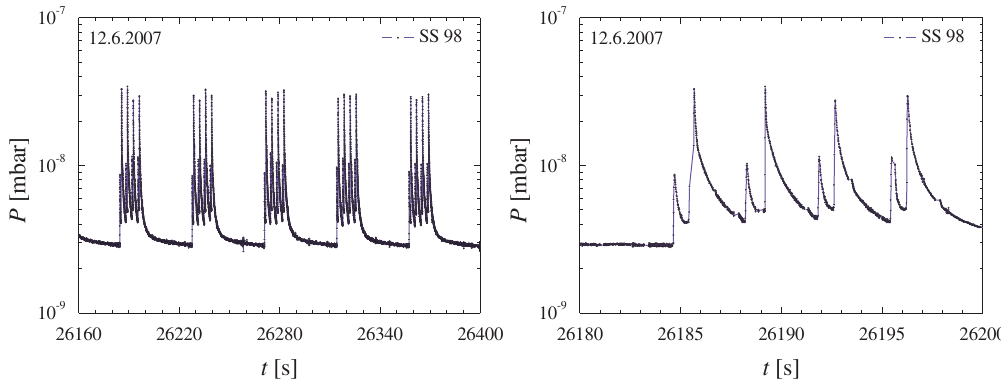
FIG. 3. (Color) Pressure rises in PS straight section 98 measured on 12/6/2007 at 21:38 during a PS supercycle that contained four nominal LHC beams. Right: Zoom into the pressure rise caused by 4 (cid:4) 72 bunches. The distance between the main peaks is 3.6 s, the smaller peaks appear about 0.8 s